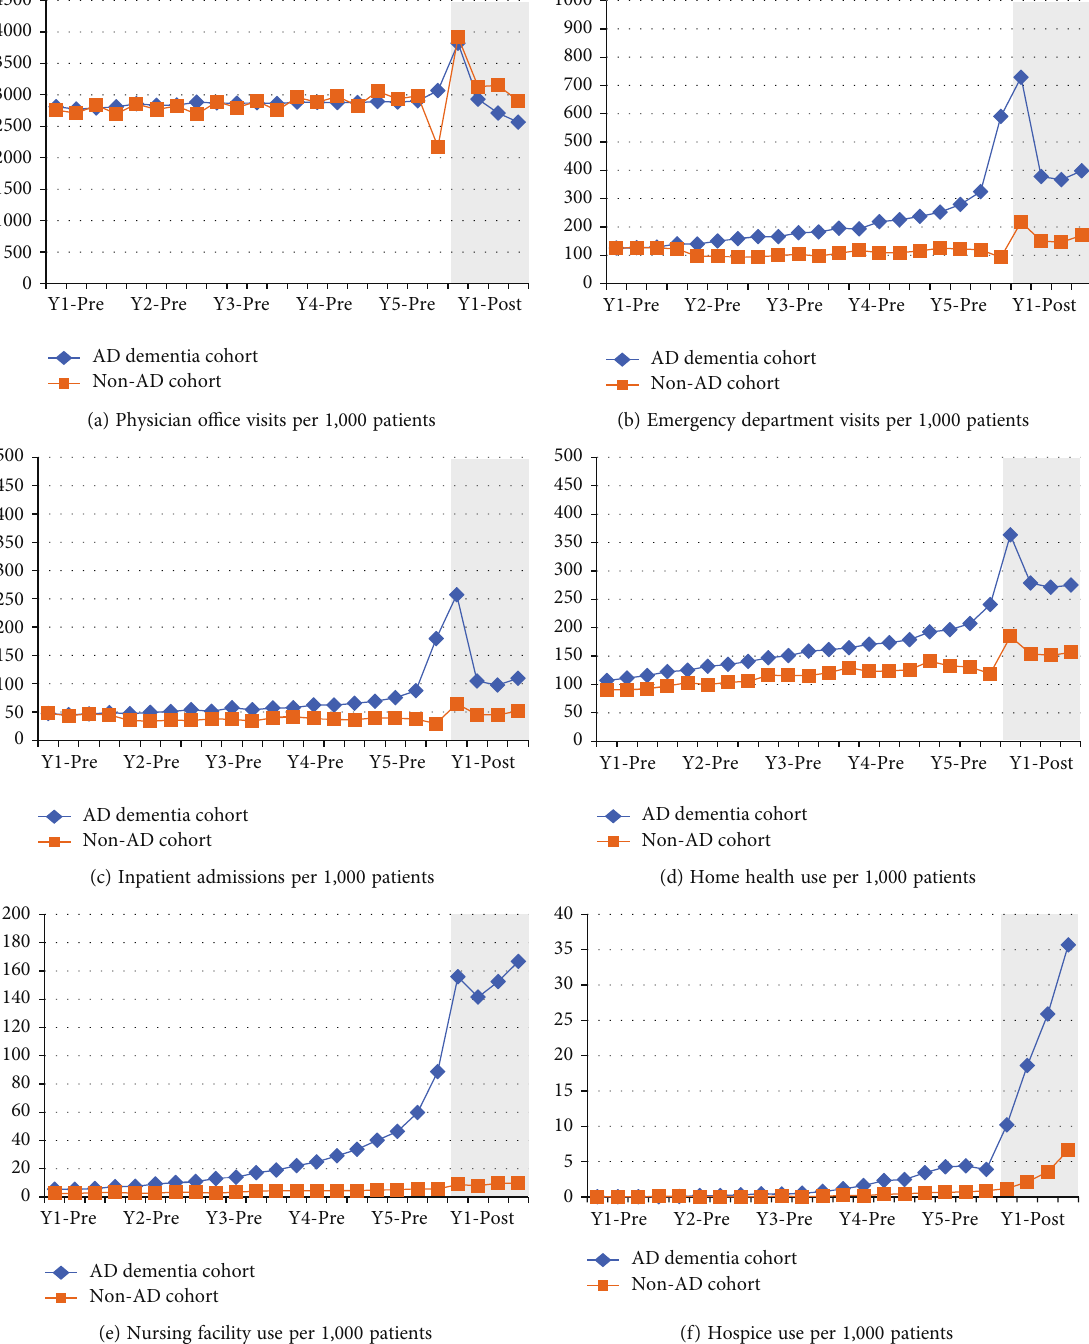
Figure 3: All-cause healthcare resource use, 5 years pre- and 1 year postindex. Grey shading indicates the 1 year postindex